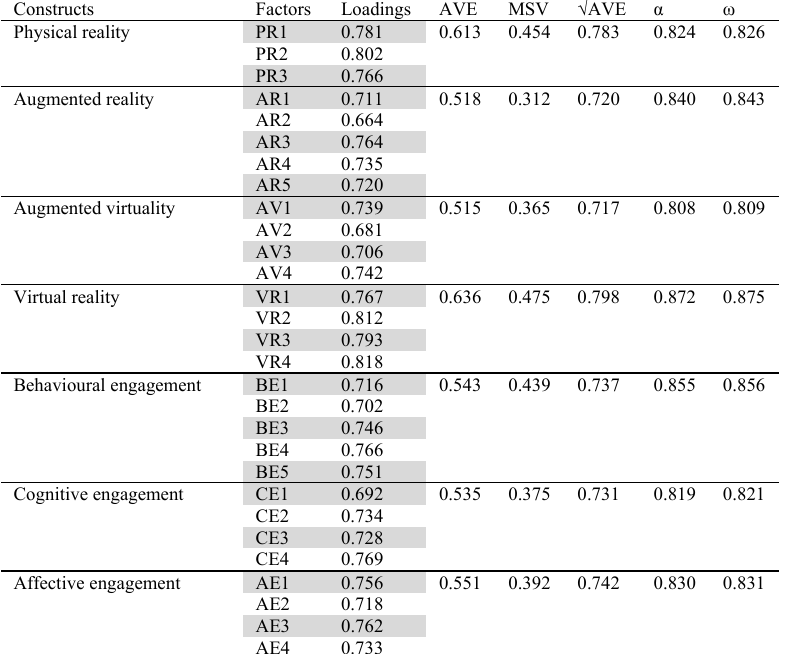
Fig. 2. Result of confirmatory factor